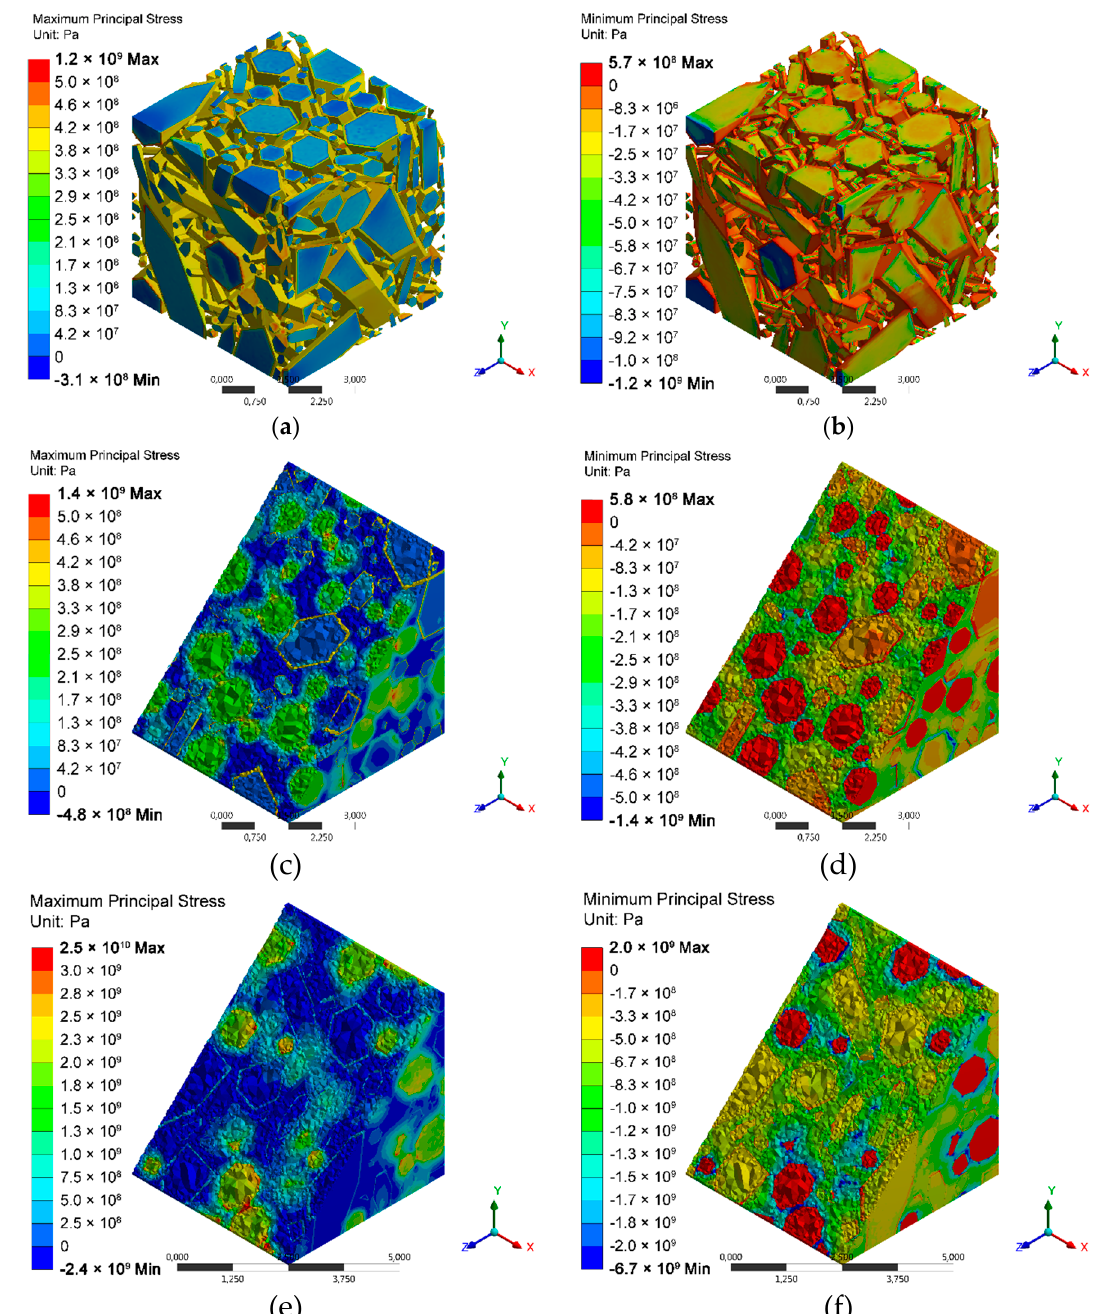
Figure 7. Distribution of residual thermal stresses: ( a ) maximum principal stresses in Si 3 N 4 , ( b ) minimum principal stresses in Si 3 N 4 , ( c ) maximum principal stresses in Si 3 N 4 + 20%SiC, ( d ) minimum principal stresses in Si 3 N 4 + 20%SiC, ( e ) maximum principal stresses in Si 3 N 4 + 20%TiN, and ( f ) minimum principal stresses in Si 3 N 4 + 20%TiN. Color scales and stress ranges for subsequent images are different.